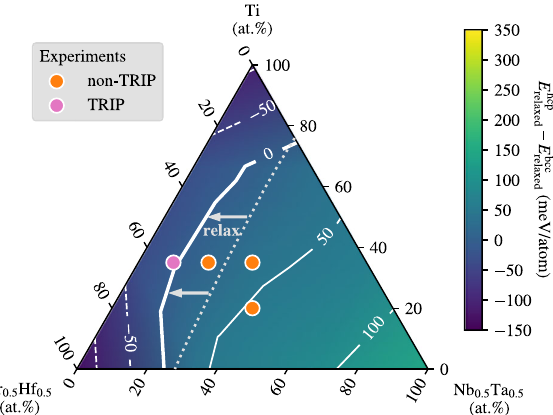
Fig. 7 Ab initio-computed relaxed energy differences between bcc and hcp for the pseudoternary Ti x (Zr 0.5 Hf 0.5 ) y (Nb 0.5 Ta 0.5 ) 1 − x − y alloys. Compositions investigated experimentally in ref. 5 are shown by the circles. The thin gray dotted line shows the bcc – hcp equilibrium composition when the atoms are fi xed to the ideal lattice sites (cf. Supplementary Fig. 8a). The two arrows highlight the impact of the relaxations. Visualization was performed using MPLTERN 56